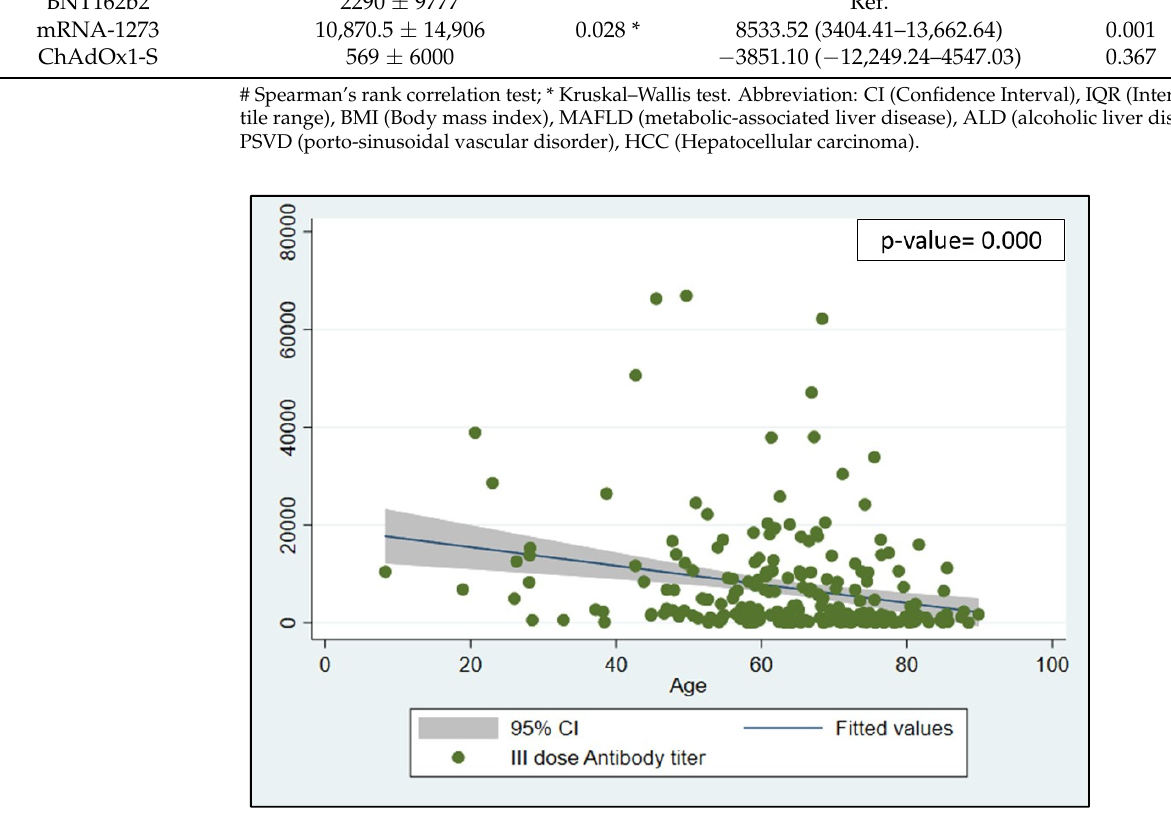
Figure 2. Scatterplot: correlation between age and antibody titer in patients with chronic liver disease. It shows an inverse relationship (Spearman rho = − 0.28; p < 0.001). Abbreviation: CI (Confidence Interval) .